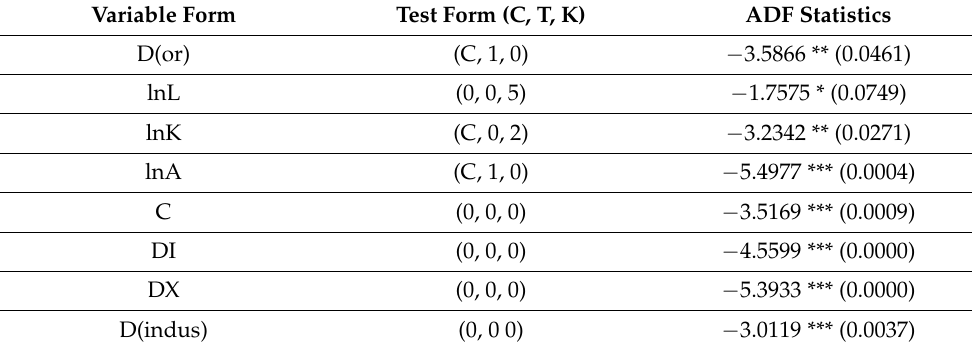
Table 1. Stationary test of each time